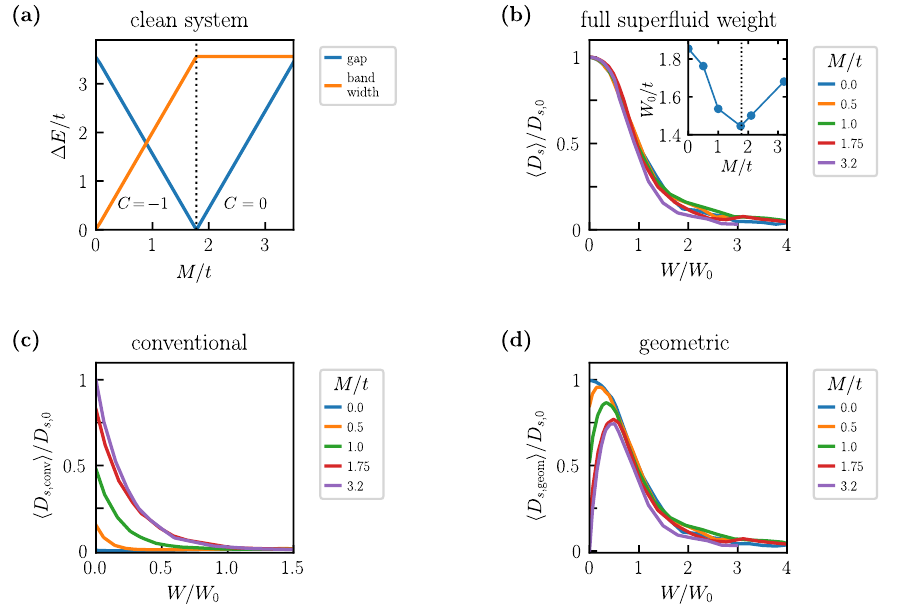
Figure 6: Properties of the extended Kane-Mele model as a function of the staggered / 100, and ¯ ν = 1 / 2: (a) Evolution of the en- onsite potential M for U = 3 t , T = T c ,0 ergy gap and the bandwidth of the lower band. We also indicate the Chern number of the lower spin-up band on the two sides of the topological transition. Full super- fluid weight (b), conventional contribution (c), and geometric contribution (d) as a function of disorder W for various values of M . The inset in (b) shows the disorder scale W as a function M 0